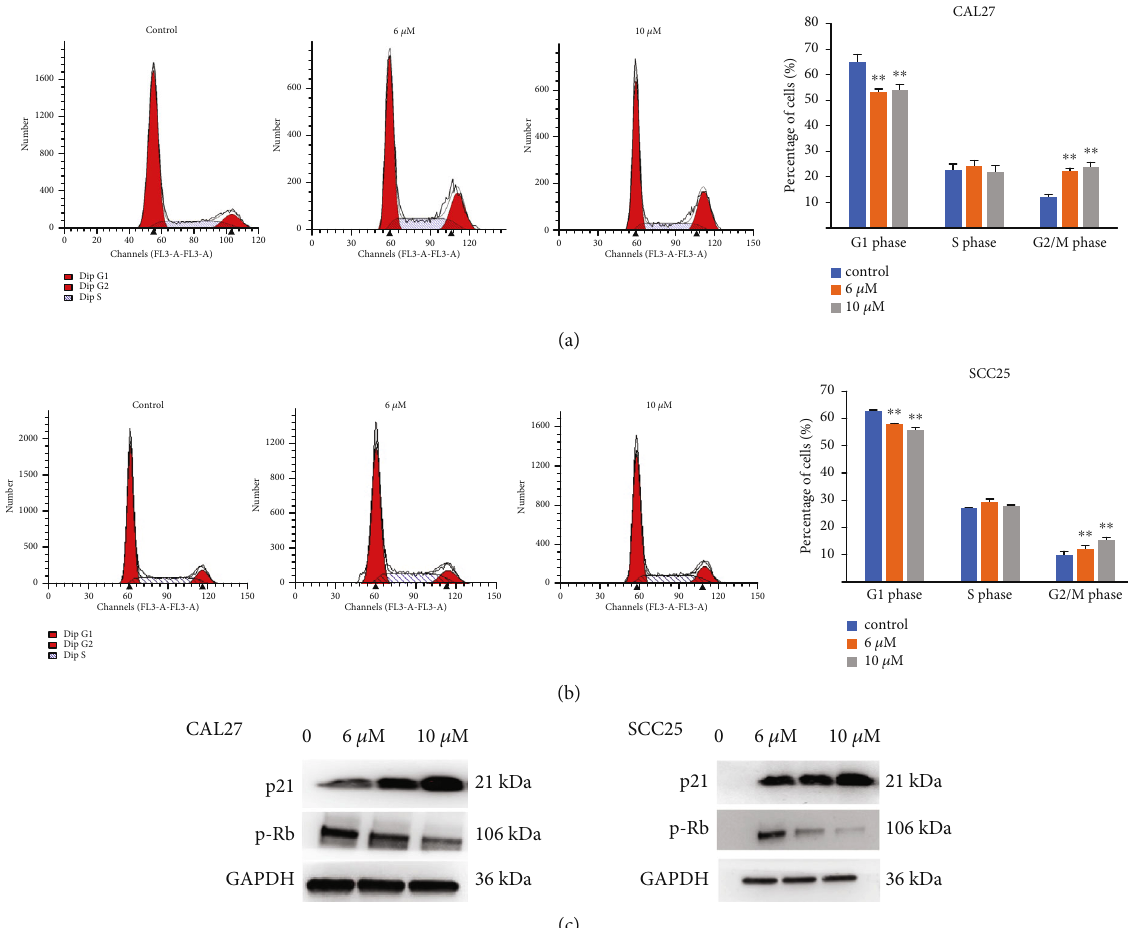
Figure 7: MK2206 2HCl induces cell cycle arrest at G2/M in OSCC cell lines. (a) MK2206 2HCl induces cell cycle arrest at G2/M in CAL27 cells. (b) MK2206 2HCl induces cell cycle arrest at G2/M in SCC25 cells. (c) MK2206 2HCl increased the protein expression of p21 and inhibited p-Rb expression by western blotting in CAL27 and SCC25 cells. All data are presented as the mean ± SD : ∗∗ P < 0 : 01 as compared with the control